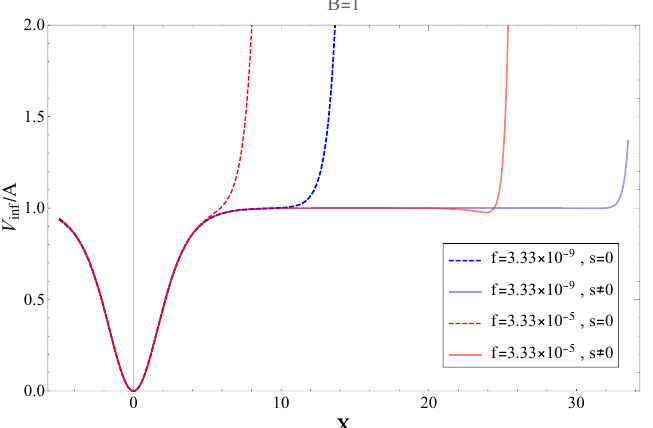
Figure 2 . The ratio of the squared mass of the real scalar fields α i , β i , y and σ , to the squared Hubble scale, with A = 3 × 10 − 10 , f = 3 . 33 × 10 − 11 , λ units where M = 1 . P